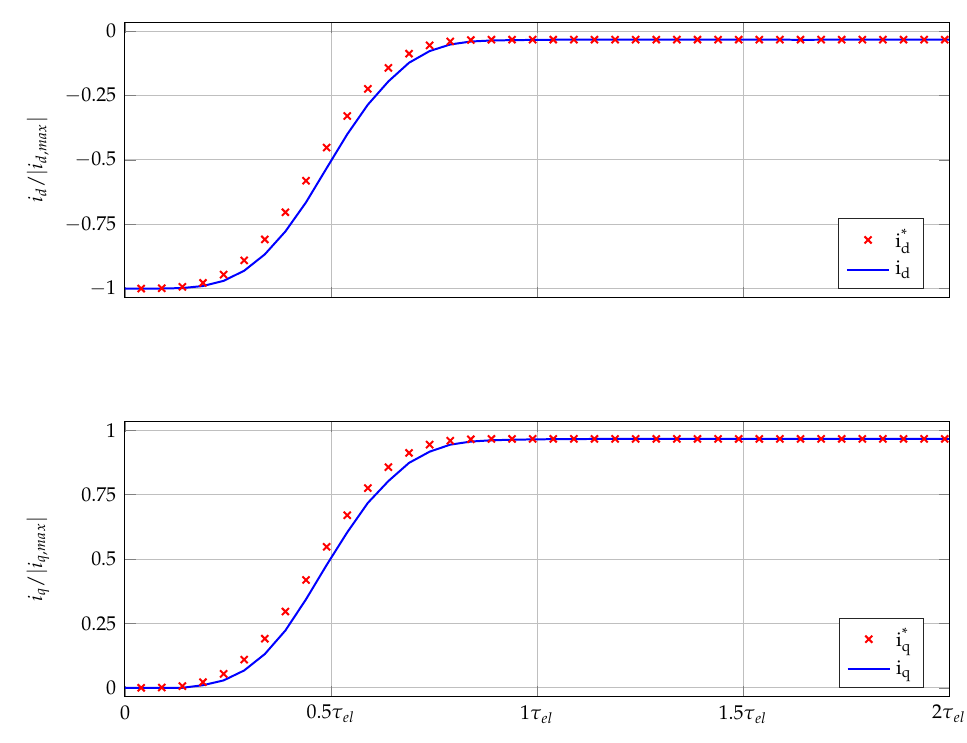
Figure 5. Tracking characteristics of the flatness-based field-oriented current controller for a simulta- neous rapid set-point change over the whole current ranges.